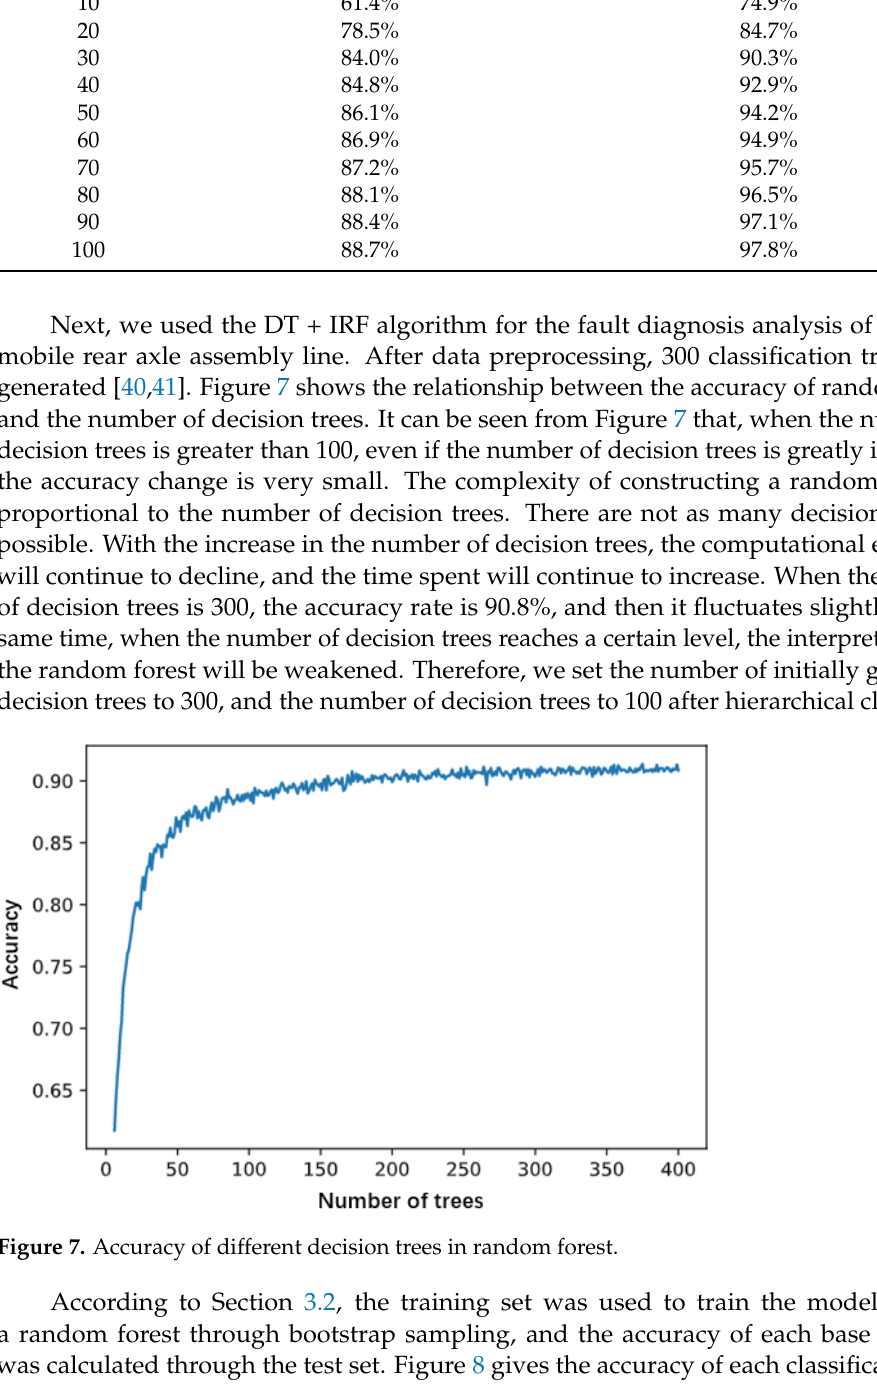
Figure 8. Accuracy of each base classifier.